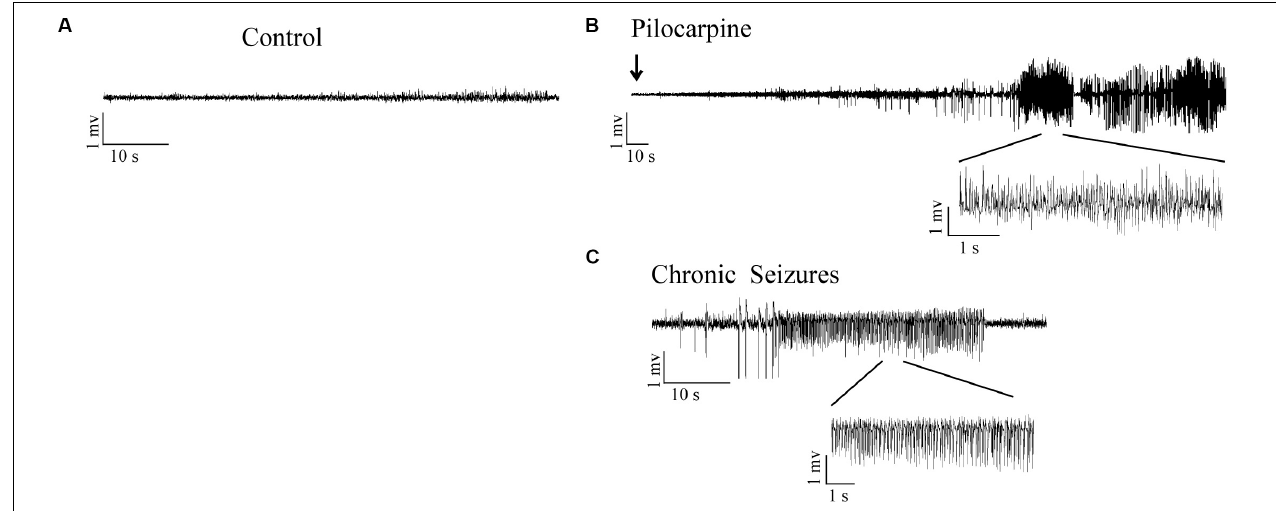
FIGURE 1 | LFPs signals in hippocampal CA3 region in response to SE induction. (A) LFPs recordings in control rats. (B) Representative recordings of pilocarpine induced SE in epileptic rats. (C) Representative recordings of the pilocarpine induced chronic spontaneous seizures (day 30 after SE).